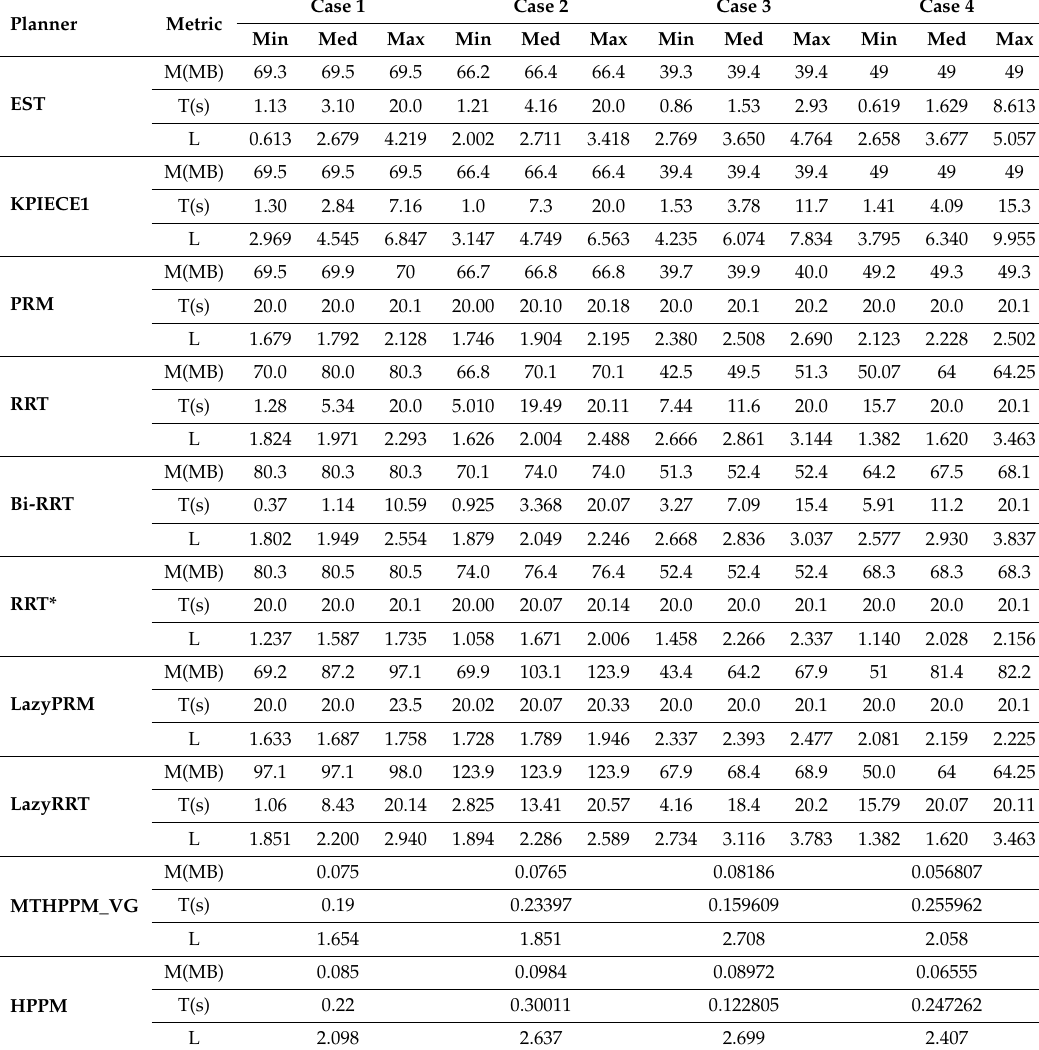
Table 3. Summarized performance results for case studies 1–4. Metrics: memory consumption (M), execution time (T), and length of path